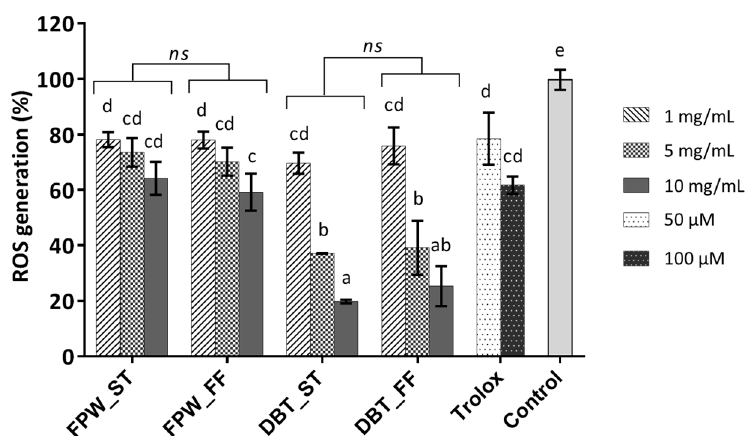
Figure 6. Extent of intracellular reactive oxygen species (ROS) generation in 2,2’-azobis (2-amidinopropane) dihydrochloride (AAPH) stressed-HepG2 cells treated with 1–10 mg/mL (final concentration) of the 4 h whey protein hydrolysates generated using FlavorPro Whey (FPW) and Debitrase (DBT) under pH- (ST) and non pH-controlled (FF) conditions. Trolox at 50 and 100 µM was used as a positive control. Values reported are mean ± SD, n = 3. Different letters indicated significant difference at p < 0.05. ns: non-significant ( p ≥ 0.05).